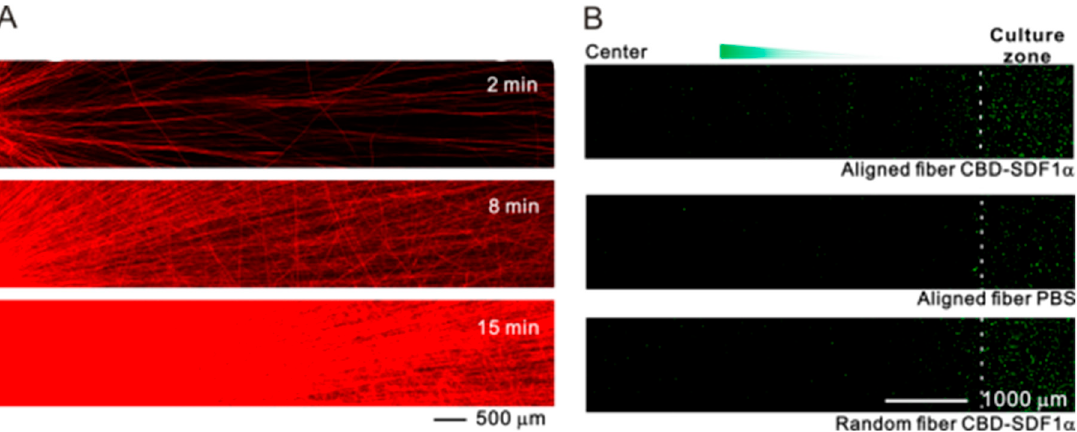
Figure 4. Radially aligned nanofibers with an immobilized SDF 1 α gradient produced by electrospinning. ( A ) Gradient patterns can be controlled by adjusting the collection time during electrospinning. ( B ) SDF 1 α gradient and aligned fibers improved NSC migration synergistically. Reprinted from Reference [43].